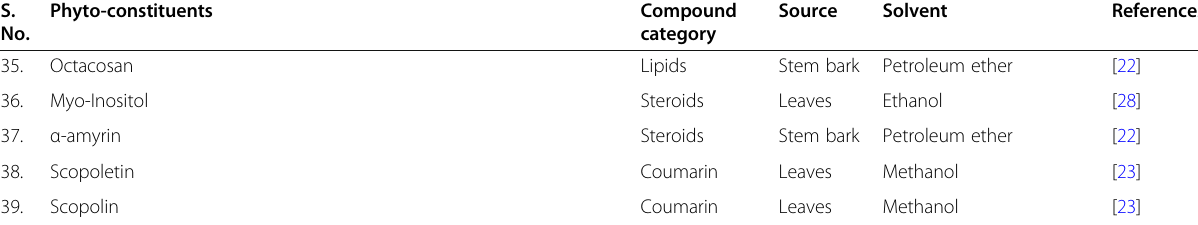
Table 2 Phytoconstituents of B . racemosa that have been extracted by different solvents